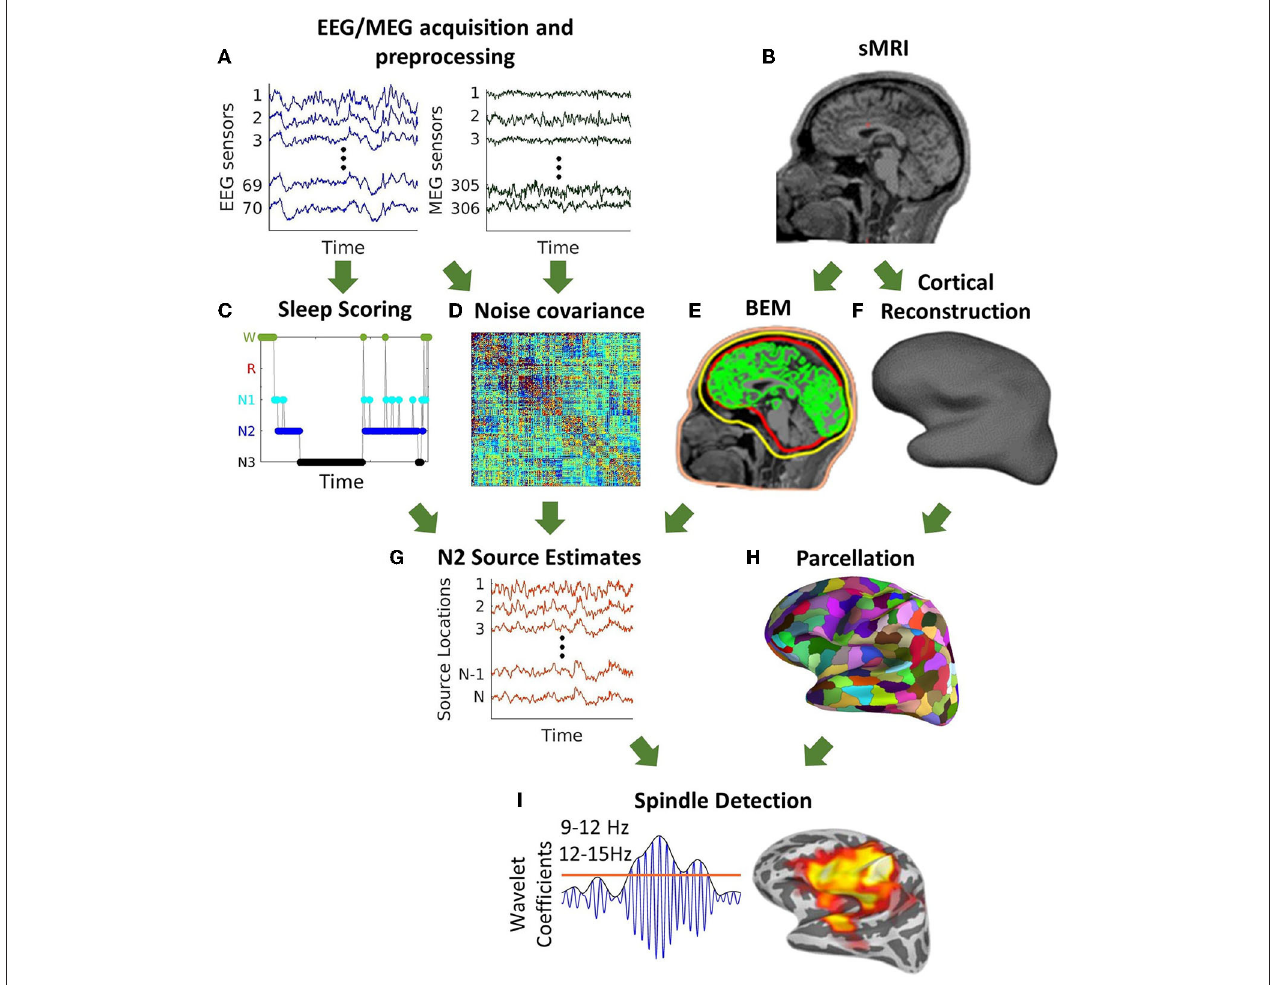
FIGURE 1 | Schematic description of source space spindle detection. (A) Pre-processing of simultaneously acquired EEG/MEG data. (B) Structural MRI. (C) Sleep scoring of nap data. (D) Noise covariance estimates calculated using the EEG/MEG data from the 5min resting-state scan filtered at 100–140Hz. (E) Construction of a three-layer boundary element model (BEM) surfaces (inner, outer skull, and scalp) for forward modeling (F) Cortical reconstruction. (G) Source estimates of N2 calculated using the cortically constrained minimum-norm estimate of cortical currents. (H) Parcellation of the cortical surface into 448 regions. (I) Automatic spindle detection at each cortical region using a wavelet-based